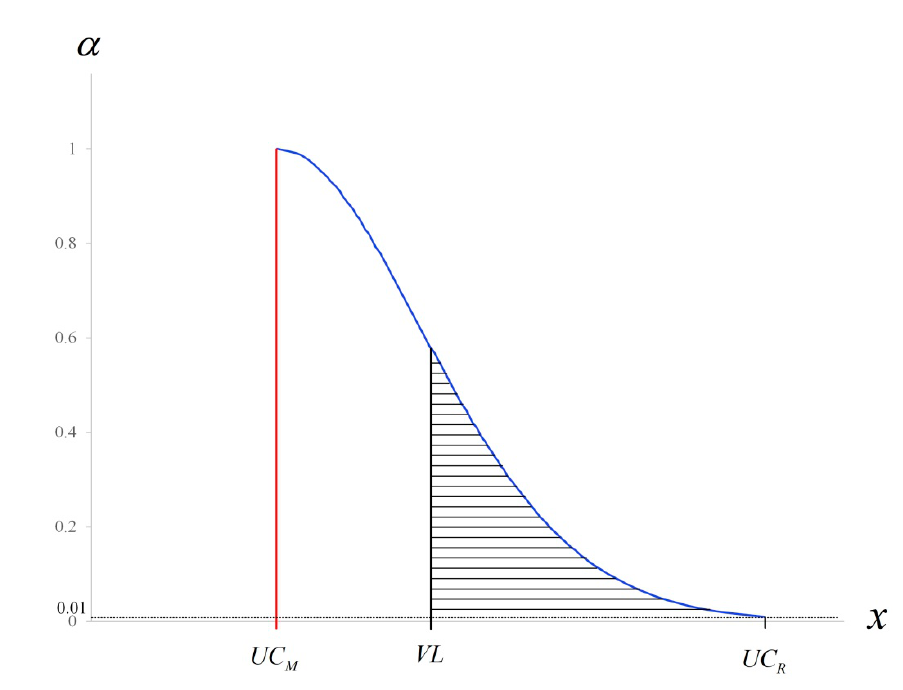
Figure 2. Membership function η ( x ) with vertical line x = VL